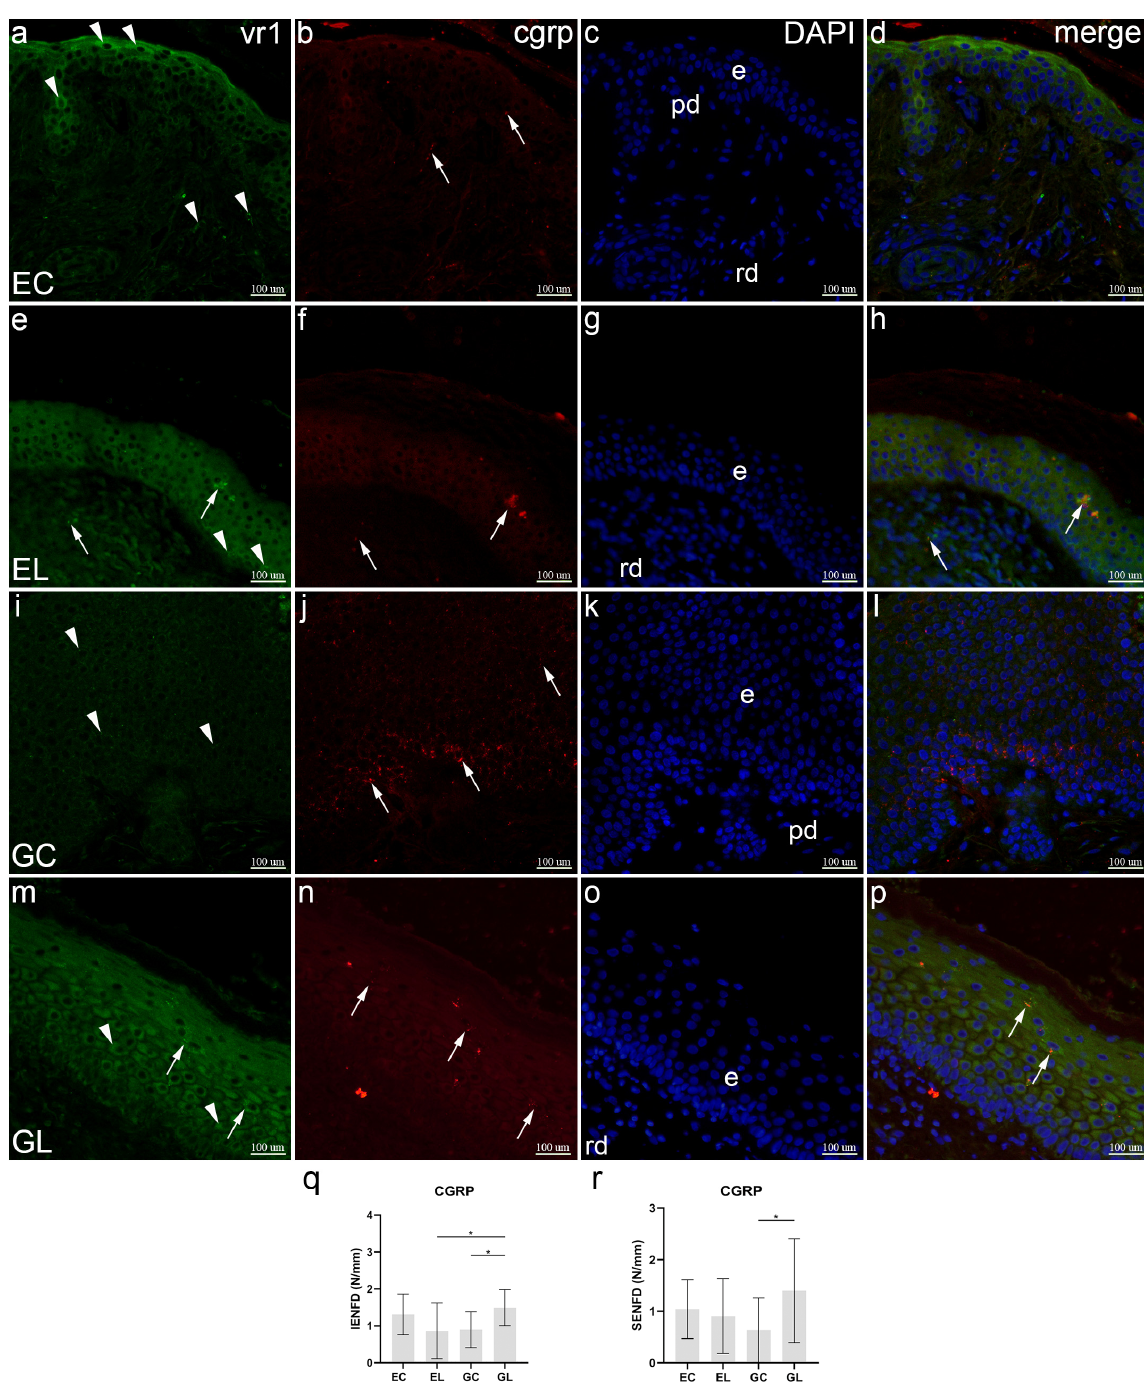
Figure 2. Co-expression of VR1 and CGRP in normal skin and lichen sclerosus skin samples. The epidermis (e), papillary dermis (pd), and reticular dermis (rd) are marked on DAPI staining images which display all cell nuclei ( c , g , k , o ). EC—normal extragenital skin ( a – d ): VR1 is expressed in several keratinocytes and dermal cells (arrowheads, ( a )); CGRP expression is observed in nerve fibers (arrows, ( b )); there is no co-expression of VR1 and CGRP ( d ). EL—extragenital skin affected by lichen sclerosus ( e – h ): VR1 is expressed in keratinocytes (arrowheads) and nerve fibers (arrows), both intra- and subepidermal ( e ); CGRP is expressed in nerve fibers (arrows, ( f )); VR1 and CGRP are co-expressed in nerve fibers (arrows, ( h )). The epidermis of this sample is thickened, which is uncommon for extragenital LS, however, other features of LS, like homogenization of the